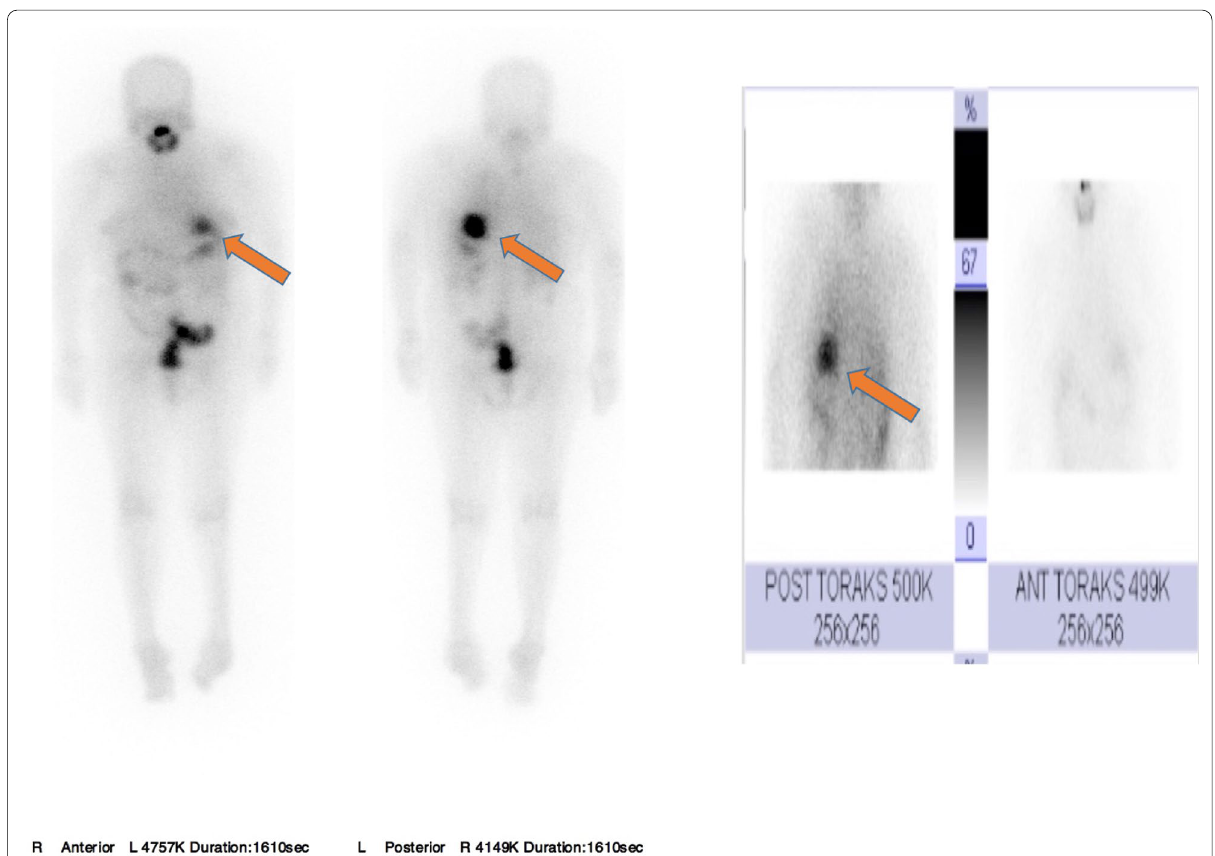
Fig. 4 (Left) Post-therapy whole-body scan (150 mCi I-131 given on 2.11.16) and (right) spot view of the thorax showed persistent tracer uptake in the left lower lung field (arrow) which is more prominent posteriorly